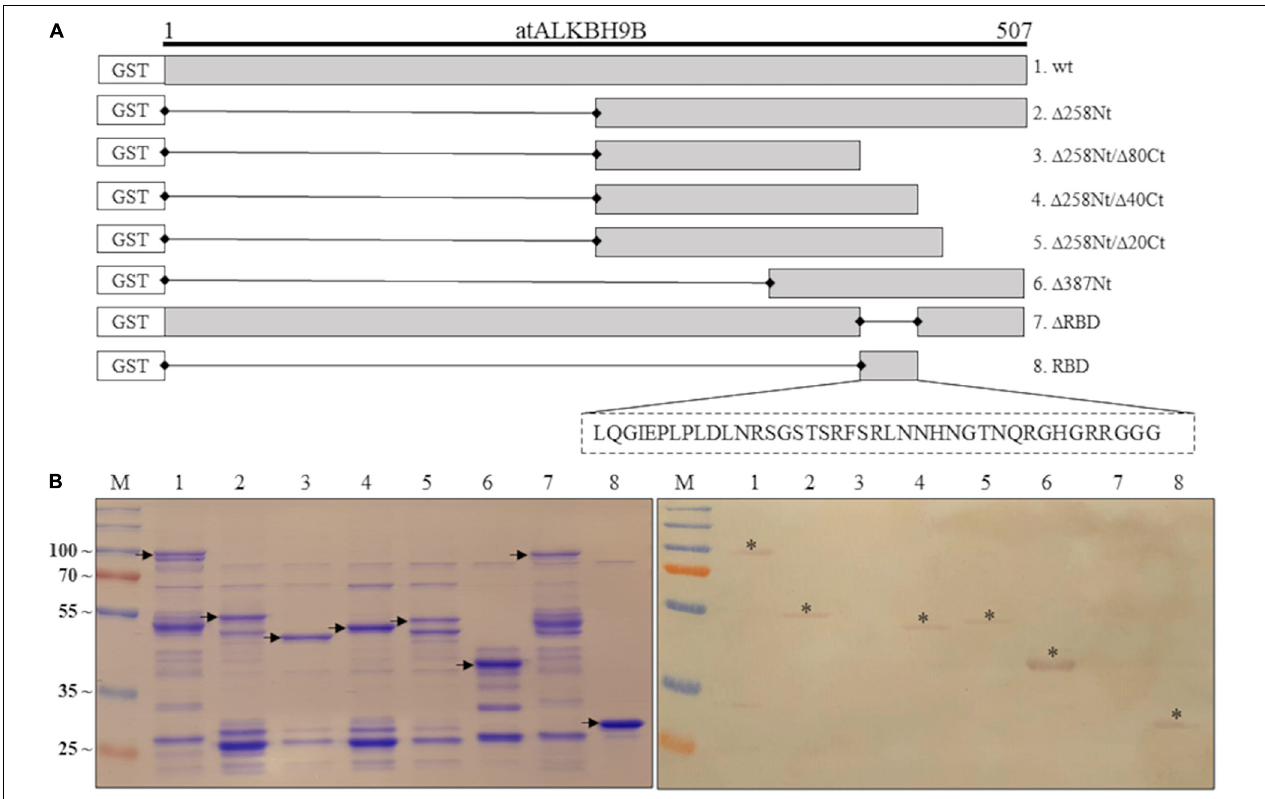
FIGURE 2 | Analysis of the RNA-binding activity of purified GST: at ALKBH9B proteins by Northwestern blot assay. (A) GST fusion proteins containing Internal or C-terminal deletions of at ALKBH9B were produced in a prokaryotic system. (B) Duplicated membranes with GST: at ALKBH9B wt (lane 1) or its mutant variants (lanes 2–8), as depicted in (A) , were resolved by 12% SDS–PAGE and, after transferring to nitrocellulose, incubated with 5 µ g of AMV-sgRNA 4 labeled with digoxigenin. The left panel shows a Coomassie blue-stained gel, and the right panel shows results from Northwestern blot analysis. Positions of full-length GST: at ALKBH9B proteins are indicated by arrows. Asterisks indicate GST: at ALKBH9B fusion proteins which interact with the AMV-sgRNA4. The positions of molecular mass markers (in kDa) are shown on the left